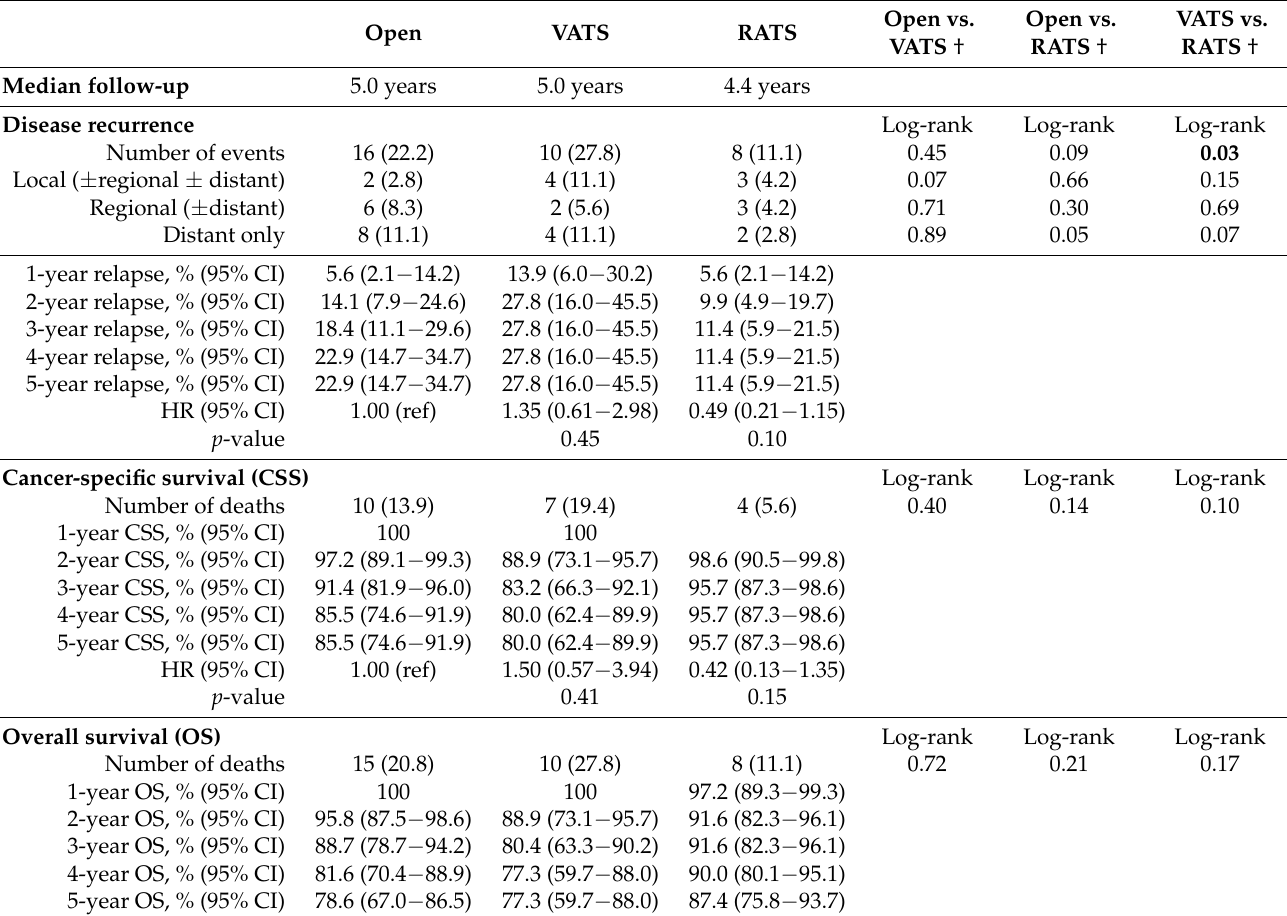
Table 3. Disease recurrence and overall survival. Open VATS RATS